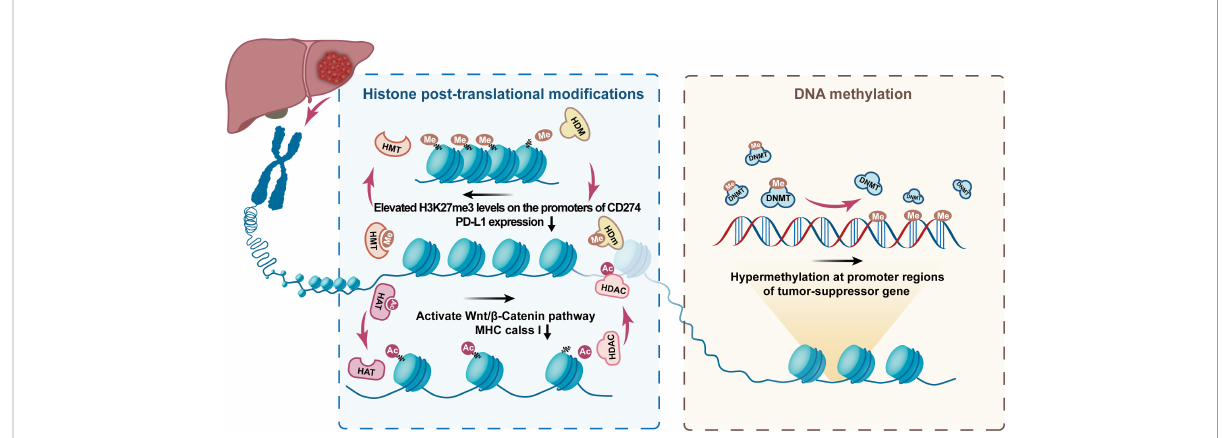
FIGURE 6 Typical histone post-translational modi fi cations and DNA methylation mechanism. The fi gure shows the role of epigenetic regulation of chromatin by DNA methylation and histone post-translational modi fi cations in the occurrence and development of HCC. The fi gure highlights the role of histone demethylase (HDM), histone methyltransferase (HMT), histone acetyltransferases (HAT), histone deacetylase (HDAC), and DNA methyltransferase (DNMT) in the formation of epigenetic characteristics of HCC. Ac, acetylation; Me, Methylation. The fi gure shows that EZH2 overexpression leads to elevated H3K27me3 levels on the promoters of CD274 and interferon regulatory factor 1 (IRF1), impeding PD-L1 expression. In, addition, the alteration caused by HDAC8 overexpression activates the Wnt/ b -Catenin pathway, which in turn impairs antitumor immunity of antigen-speci fi c T cells resulting in ICI